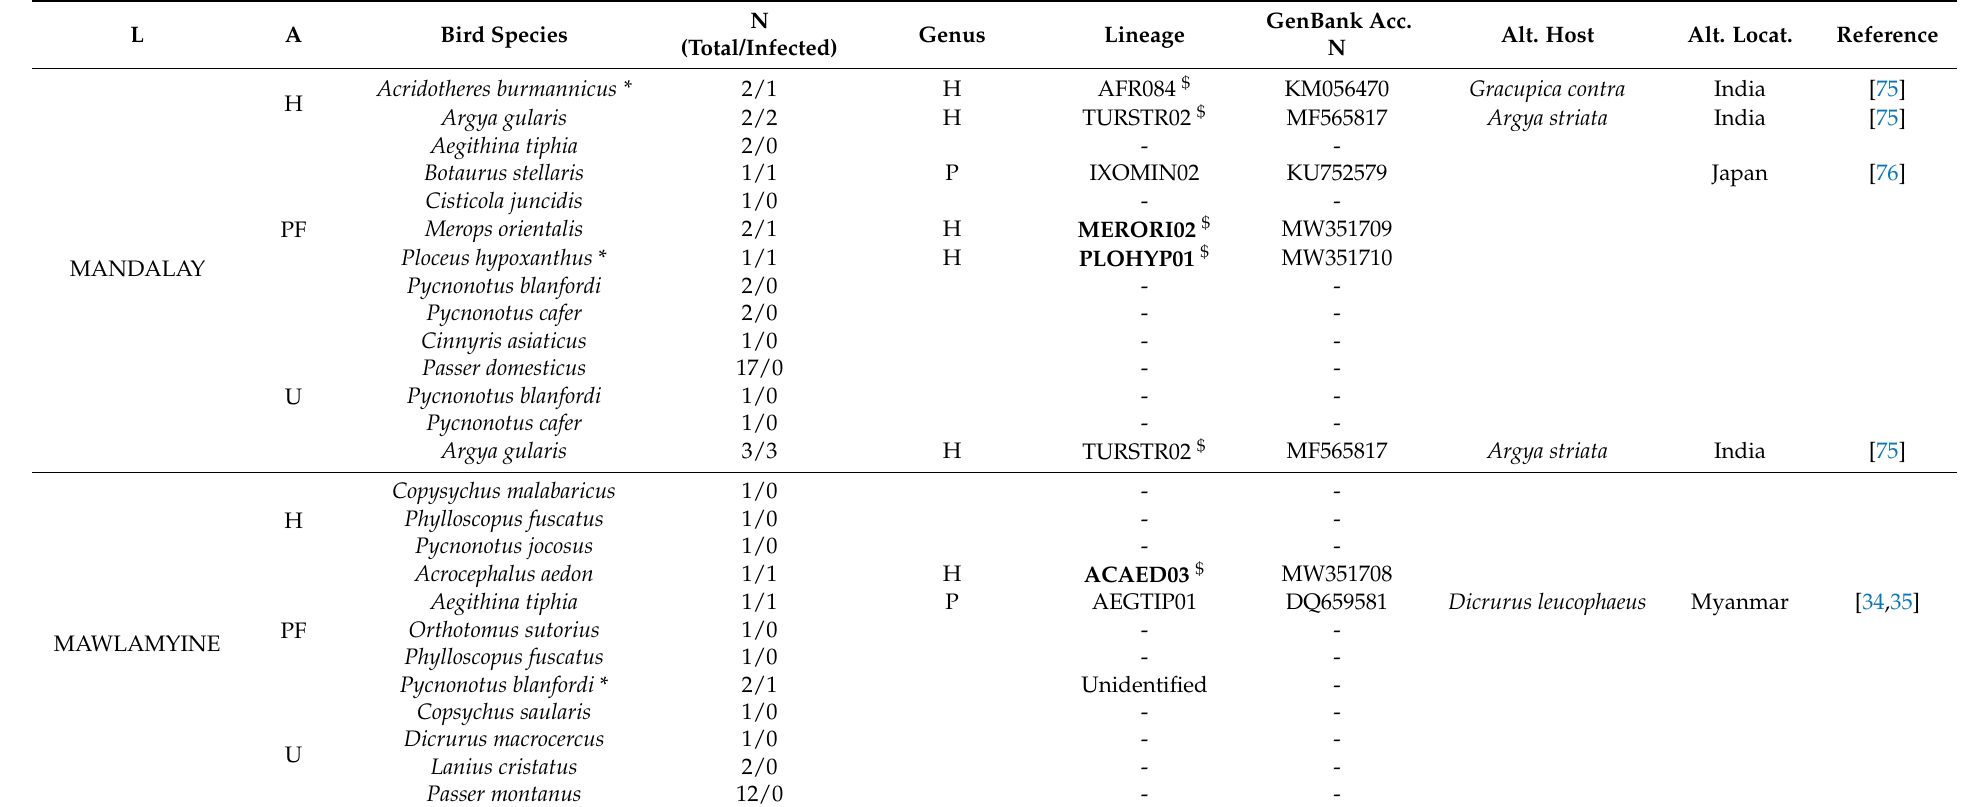
Table 1. Number of individuals sampled and infected per bird species, locality (L) and area (A) (H = hill, PF = paddy field, U = urban), lineage names, parasite genus (H Haemoproteus , P Plasmodium ), GenBank accession numbers, and alternative hosts (Alt. hosts), alternative location (Alt. locat.) and study reference in which parasite lineages were previously recorded. Asterisk (*) in bird species denotes that these bird species were not previously documented infected by haemosporidians, where symbol $ represents new host record for this haemosporidian lineage. New parasite lineages are indicated by bold letters (according to MalAvi database, Version 2.4.7, 6 October 2020,